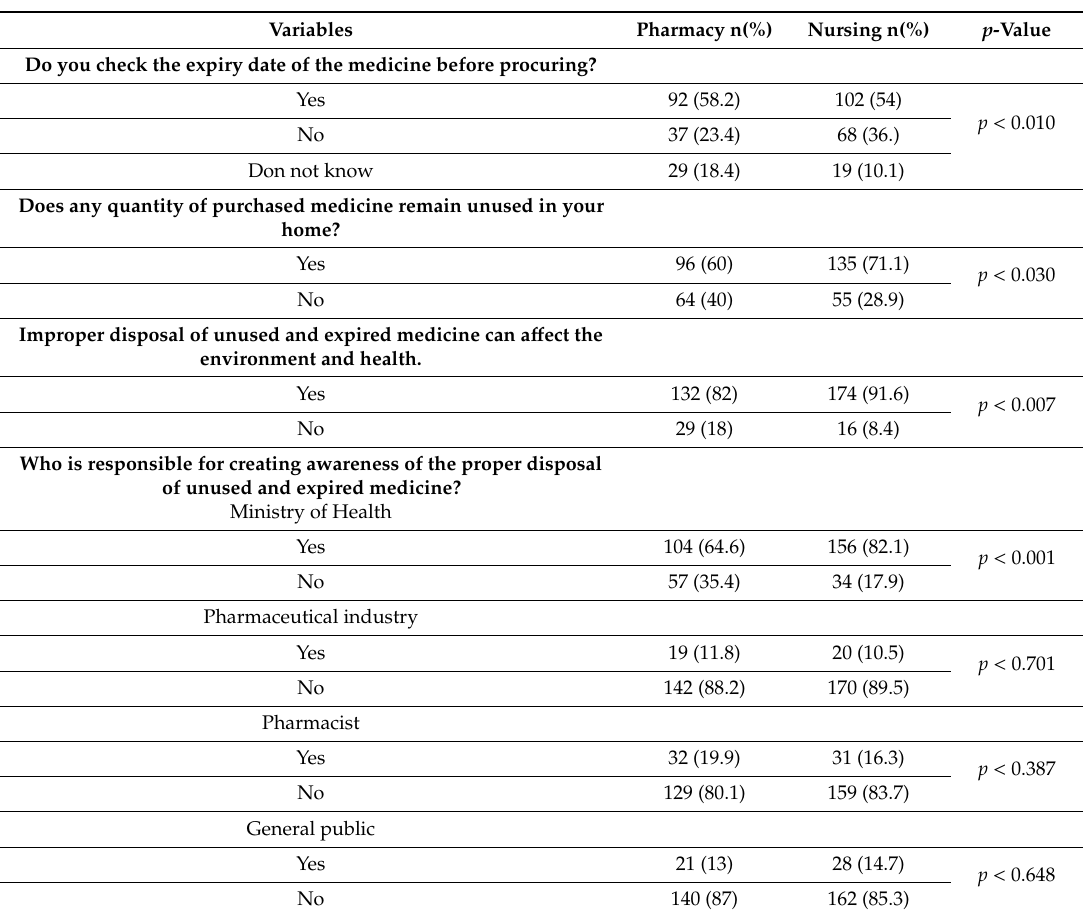
Figure 1. Most common classes of drugs purchased by respondents. Table 3. Association between study participants’ responses in selected variables.